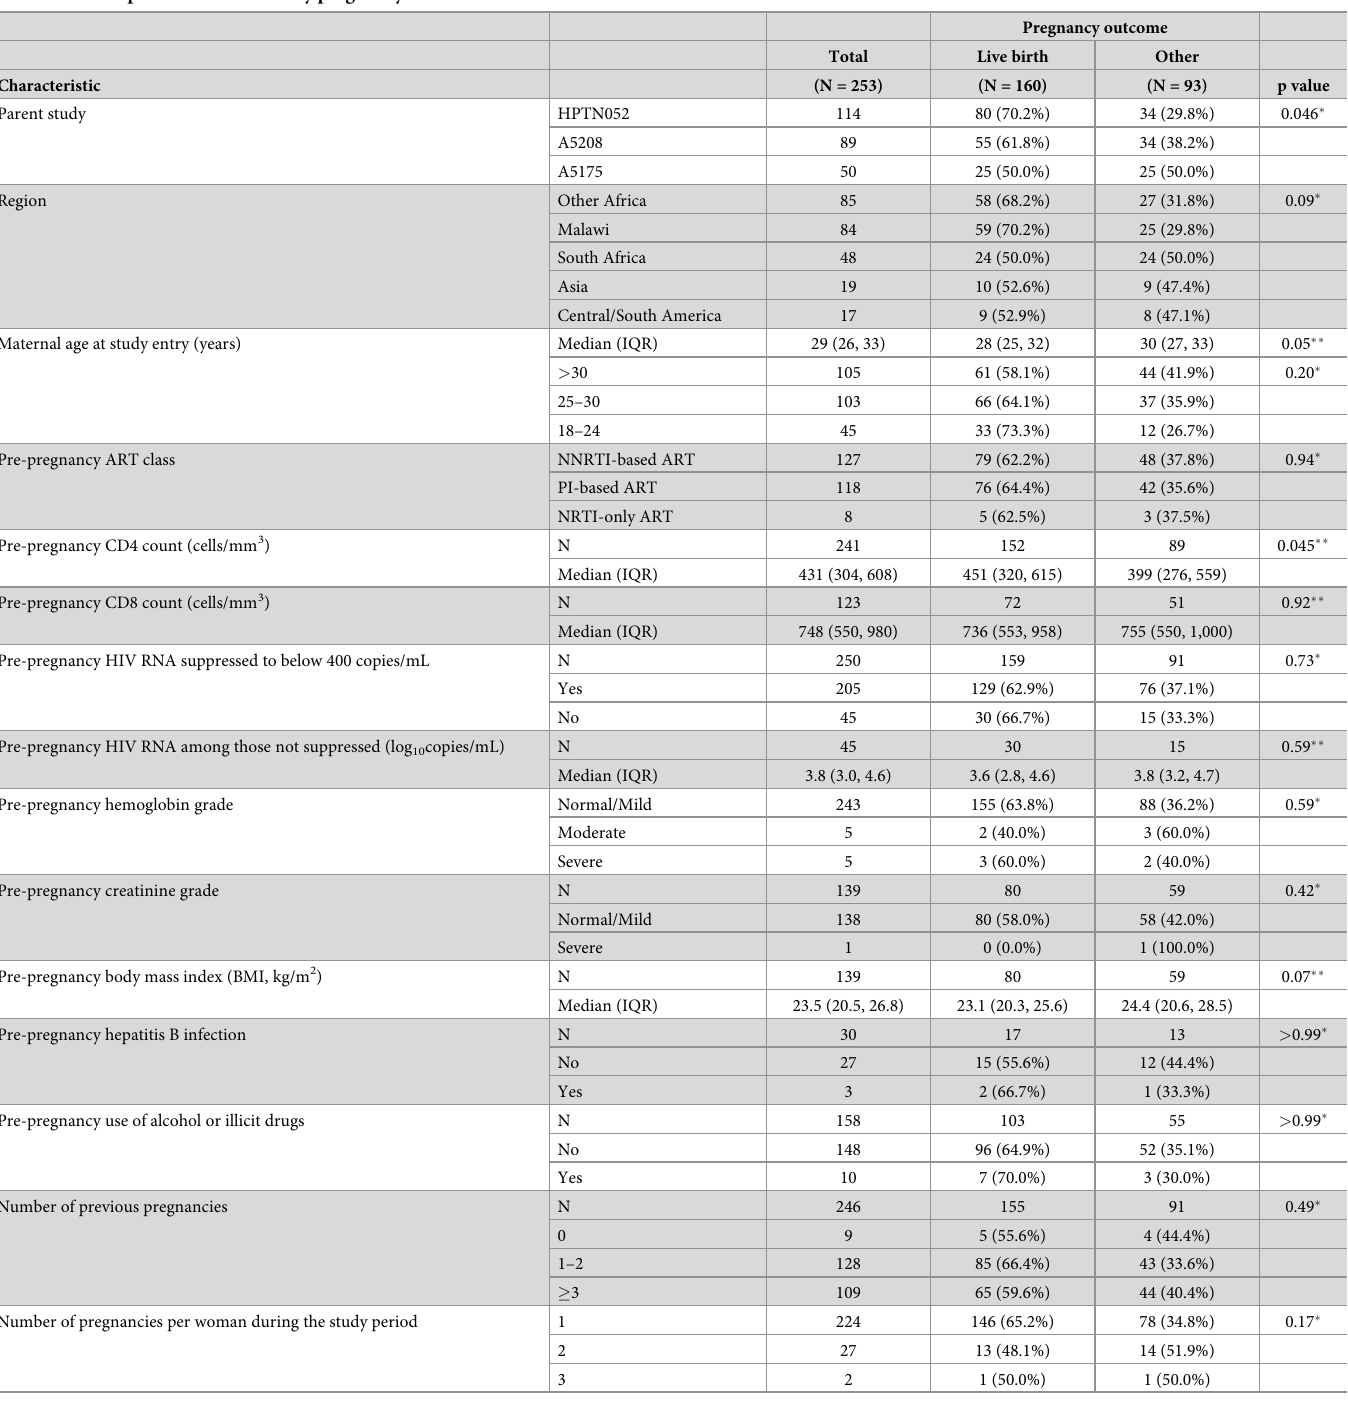
Table 3. Participant characteristics by pregnancy